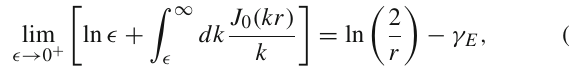
with the last integral being infrared divergent ( q → 0 )